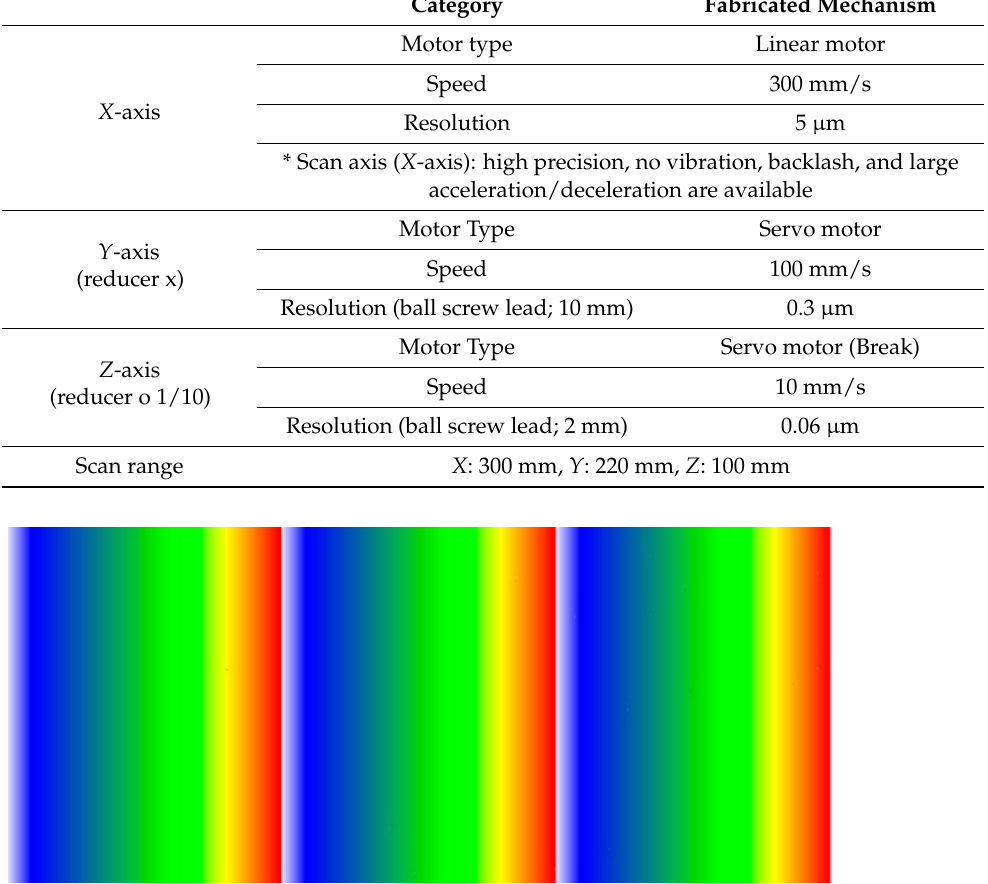
Figure 6. Constructed Activation Module and Data Acquisition System.